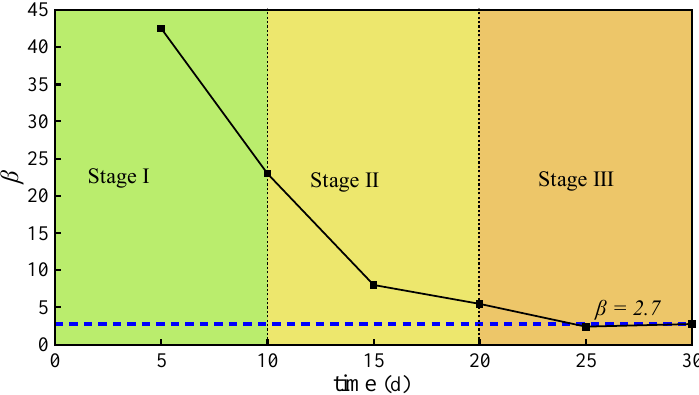
Figure 16. Time-varying reliability of ground surface settlement of the excavation.